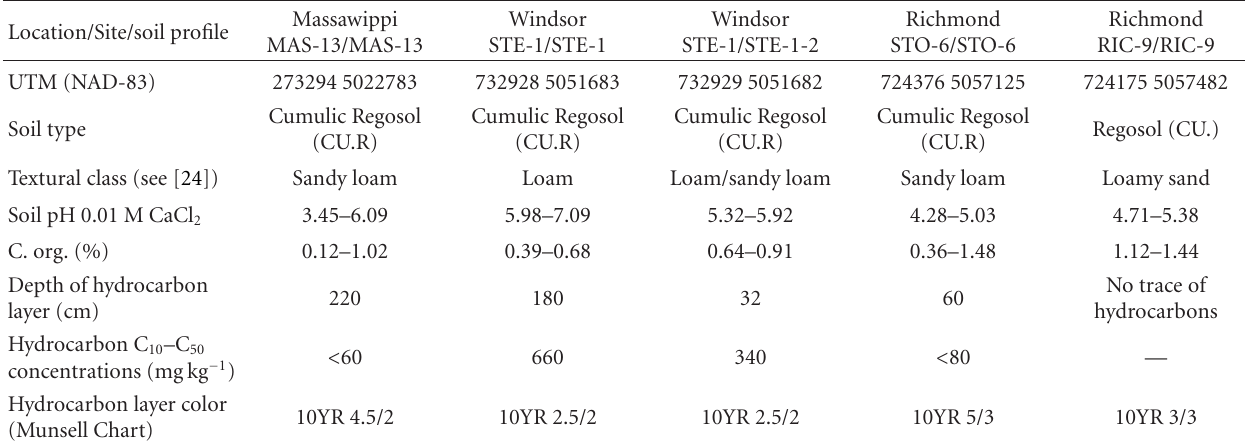
Table 1: Description of sampling sites and some characteristics of soil